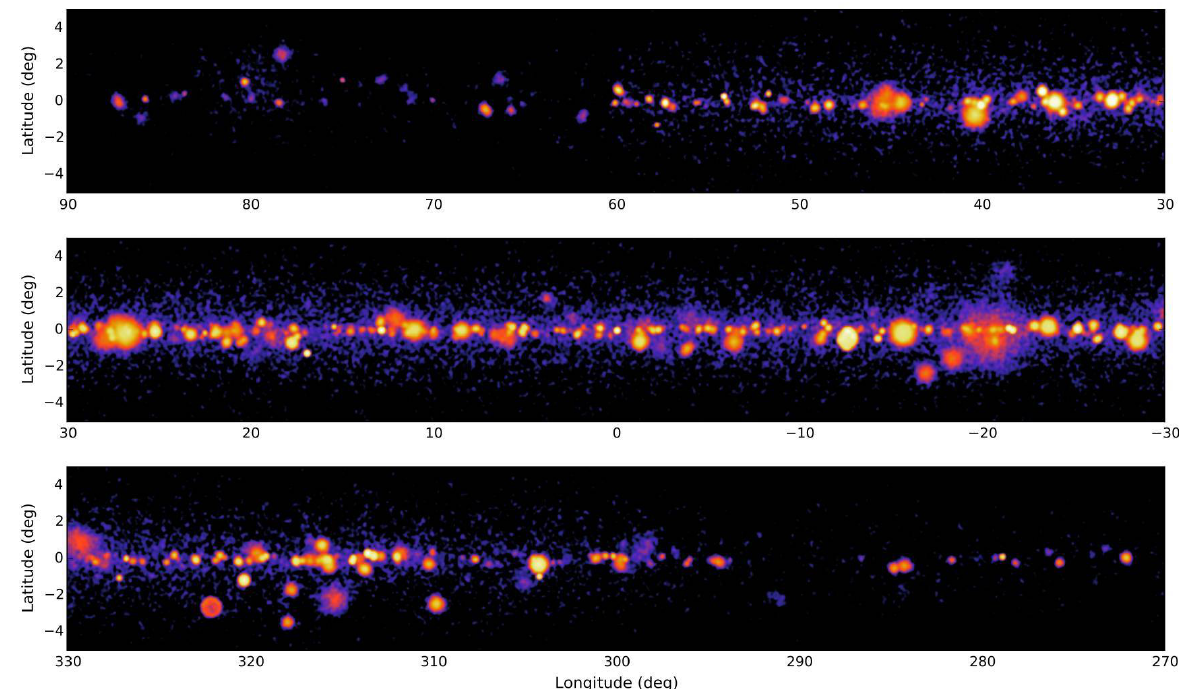
Figure 19. Simulated results from the CTA Galactic Plane Survey in very high-energy γ rays for half of the plane. Reproduced from